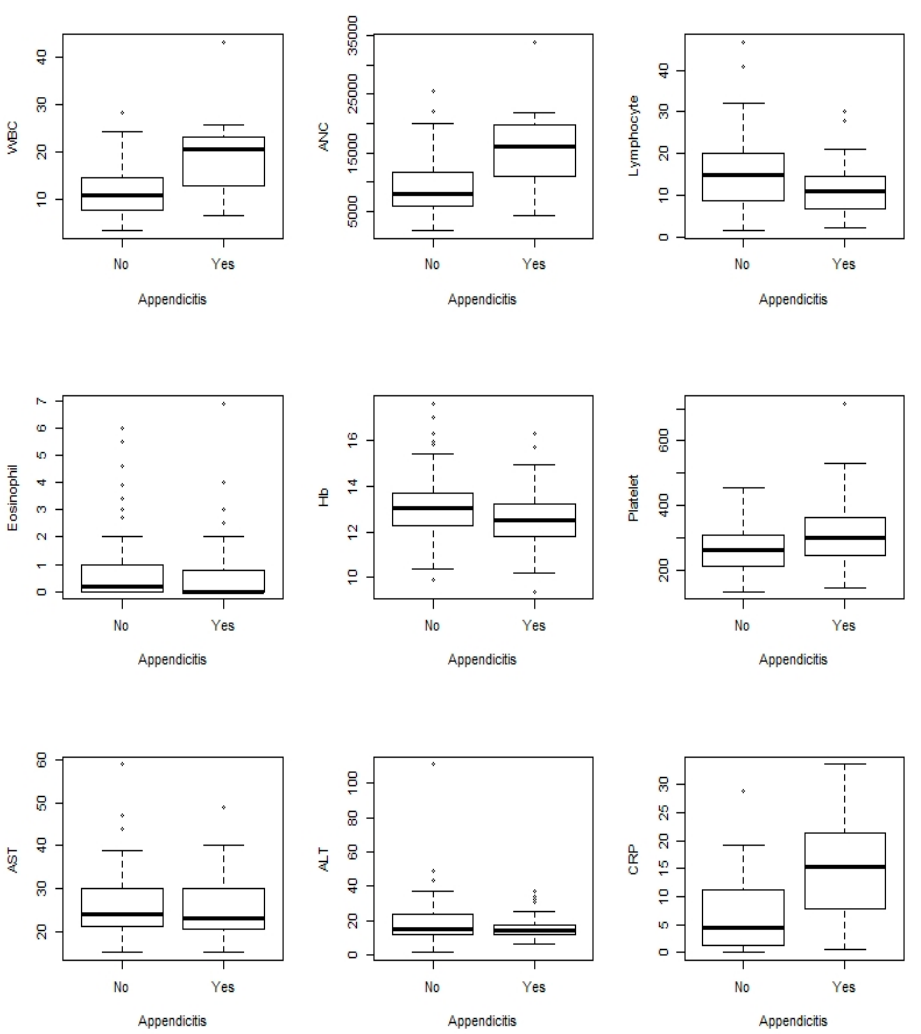
Figure 1. Boxplot for the laboratory data. WBC = white blood cell; ANC = absolute neutrophil count; AST = aspartate aminotransferase (U / L), ALT = alanine aminotransferase (U / L); CRP = C-reactive protein (mg/dL).